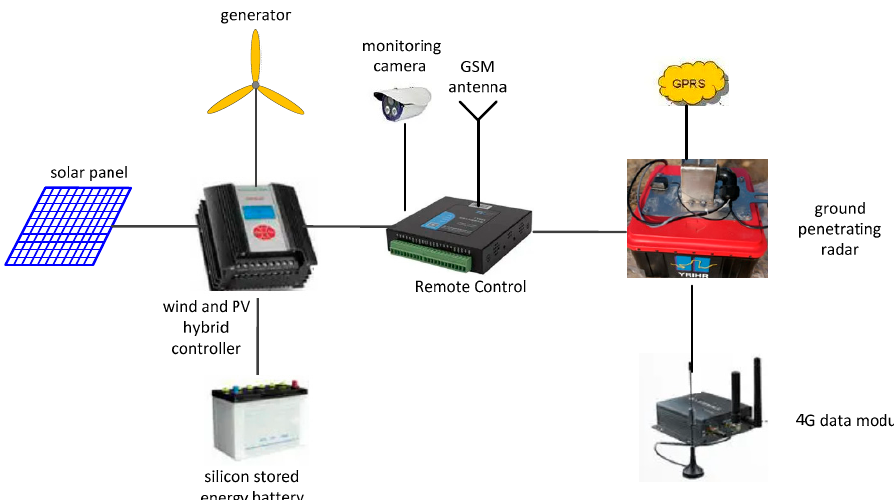
Figure 1. Schematic diagram of the air-coupled radar remote monitoring device system. Air-coupled ground penetrating radar (GPR) is the core component and is used to detect the ice thickness and the distance between the water surface and the radar. The remote computer sends parameters (sampling points, sampling frequency, accumulation times, acquisition interval, etc.) to the radar through a 4G network and displays, pro- cesses, and saves the radar data. After receiving the command, the radar collects the signal and returns the data. The technical parameters are shown in Table 1. Table 1. Technical parameters of GPR. Parameters